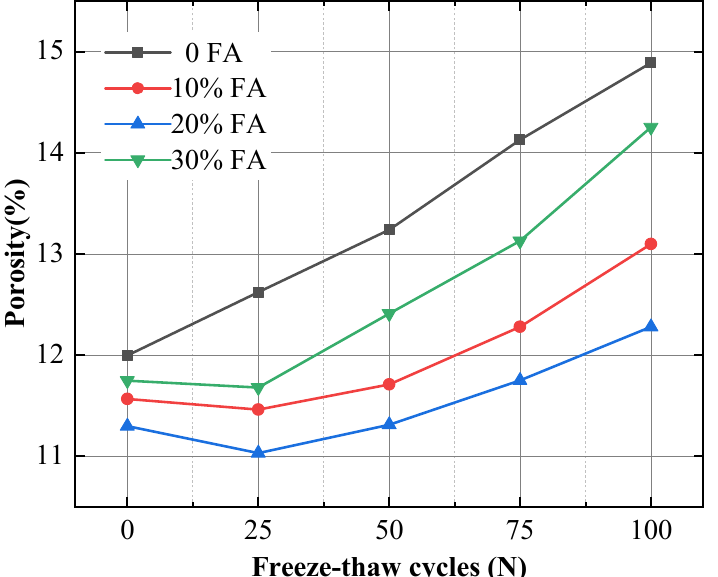
Figure 8. Porosity of concrete with different FA contents.